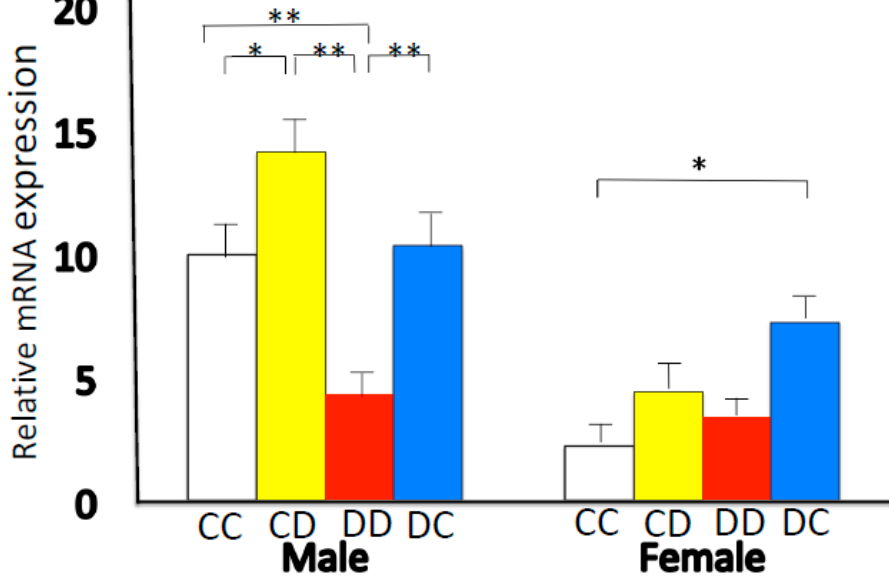
Figure 1. Hepatic mRNA expression levels of Hsd11b1. After delivery, foster mothers fed the same or different diets: CC, DD, CD, and DC (first letter: diet of original mother; second letter: diet of nursing mother. C: control diet; D; calcium-deficient diet). Data are represented as the means ± standard error. * p < 0.05, ** p < 0.01. This figure is quoted from Takaya J et al. PLoS ONE 2014 , 9 , e84125 [93].